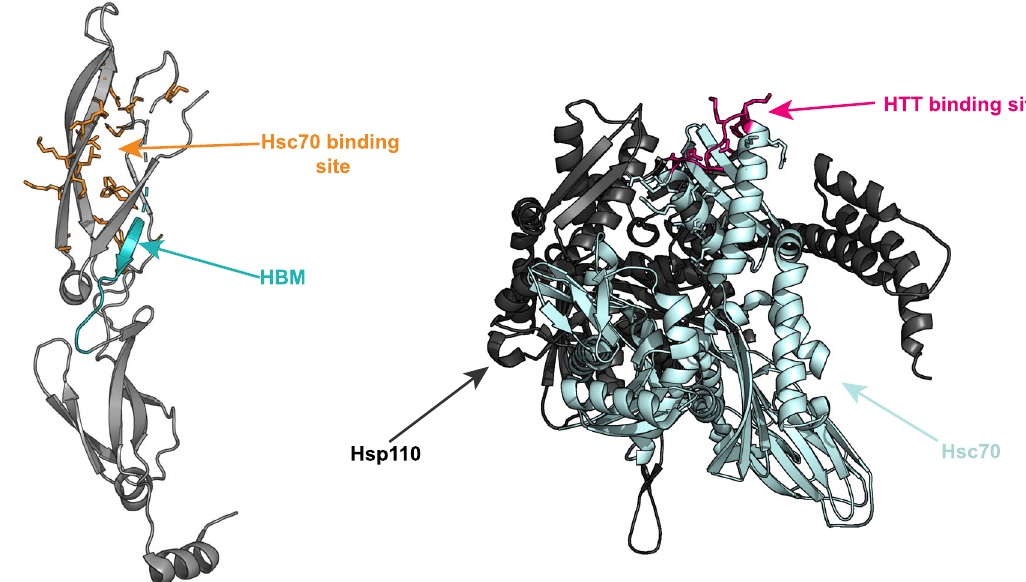
Fig. 7 | DNAJB1 G/F-rich domain contributes to the suppression of HTTEx- on1Q 48 aggregation. a Schematic representation of class B J-domain protein DNAJB1 wt (in teal) and class A J-domain protein DNAJA1 wt (in orange) and their domains. DNAJA1 possesses a similar HBM in its hinge region as DNAJB1. H and K residues are conserved (black squares). To create DNAJA1 JB1ized , DNAJA1 ZFLR was deleted,and theshortG/F-rich domainof DNAJA1wassubstituted by the longerG/ F-richdomainof DNAJB1. b FRETassayofHTTExon1Q 48 aggregationandtheeffect oftheadditionofHsc70,Apg2,andDNAJB1 wt ,DNAJA1 wt orvariantDNAJA1 JB1ized .The graph is a representative result of three independent experiments, and a one-way